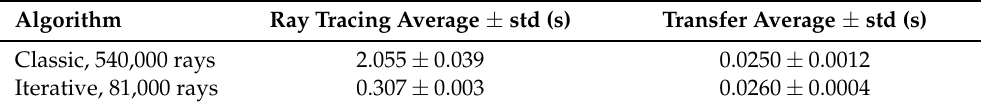
Table 3. Comparison of the time consumption for the classical algorithm and for the iterative algo- rithm. Computation time is presented for the ray tracing simulations and the transfer of simulation results from the graphics card to the host